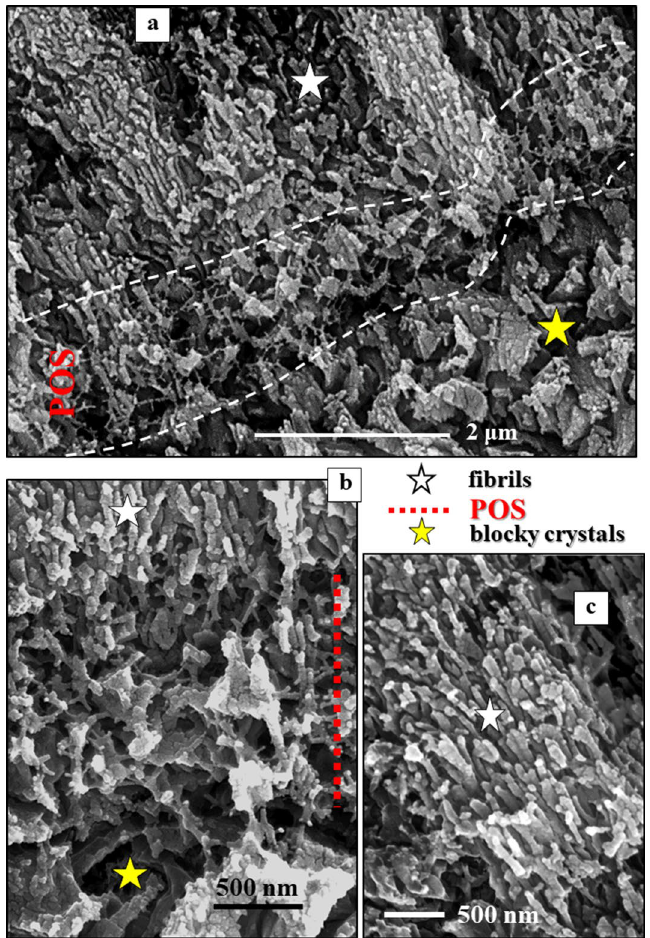
Figure 2. BSE images of shell cross-sections depicting the site of the primary organic sheet (POS, a , b ) as well as the two microstructures that comprise the shell of Pulleniatina obliquiloculata : blocky crystals (yellow star in ( a , b )) within and below the POS, and nanofibrils (white star in ( a , b , c )) above the POS. See also Fig. S2. The nanofibrils nucleate within the POS; clusters of parallel nanofibrils form elongated, sheaf-like, crystals (white star in ( c )). The latter crystals form most of the outer shell wall . The blocky crystals form the entire inner shell wall , the layer below the POS